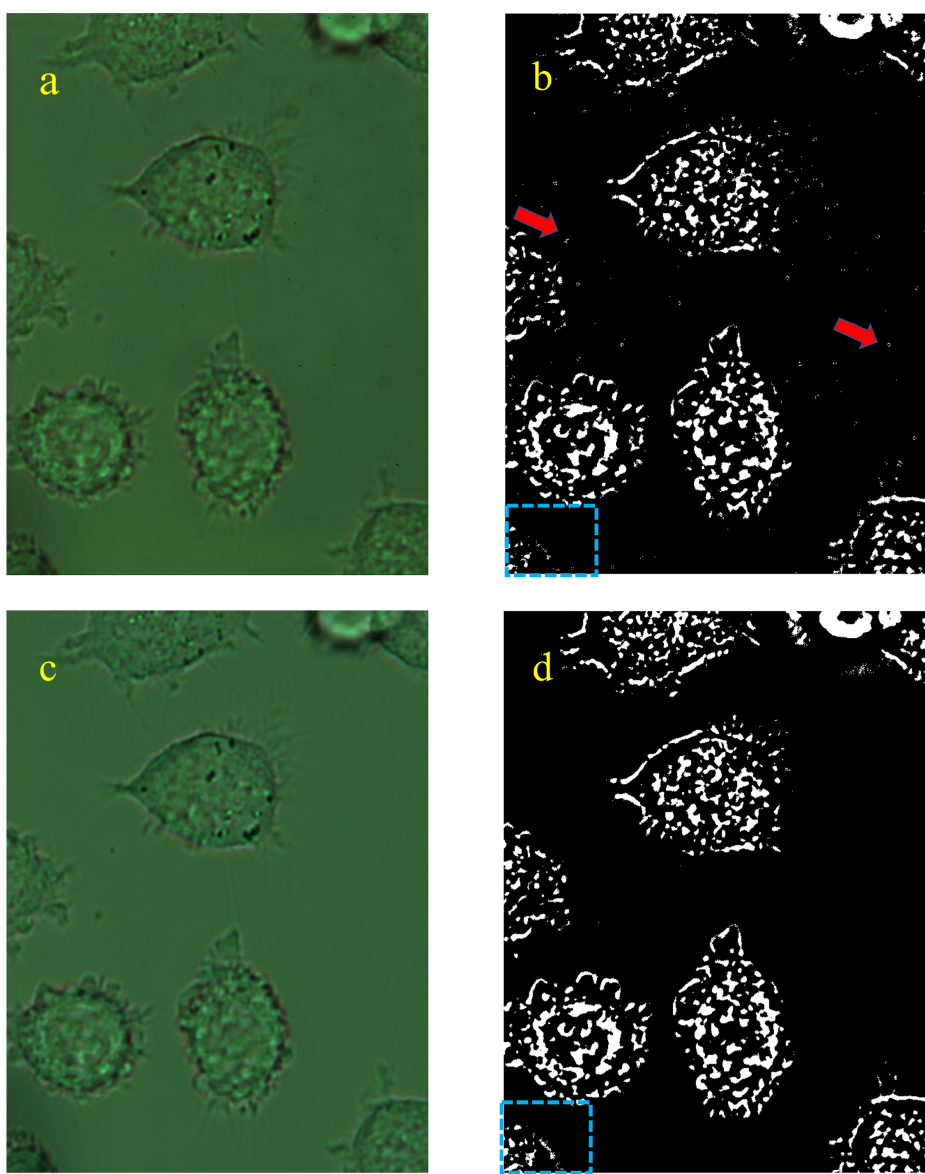
Figure 10. Conversions of a mouse fibroblasts’ image using simple Matlab functions. ( a ) 8-bit representation of a 12-bit-per-channel original uncorrected rgb image, ( b ) binarized image, ( a , c ) 8-bit representation of a corrected rgb image, ( d ) binarized image ( c